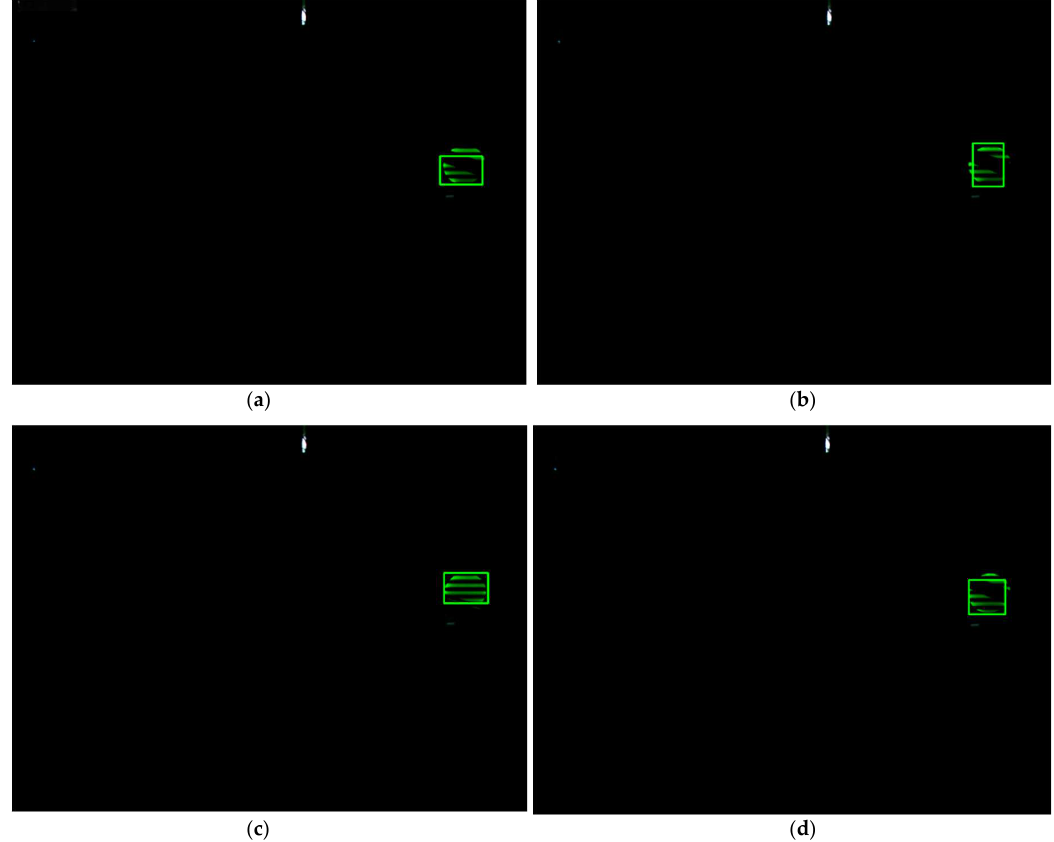
Figure 11. Target signal source LED selection and tracking algorithm initializing without interference.